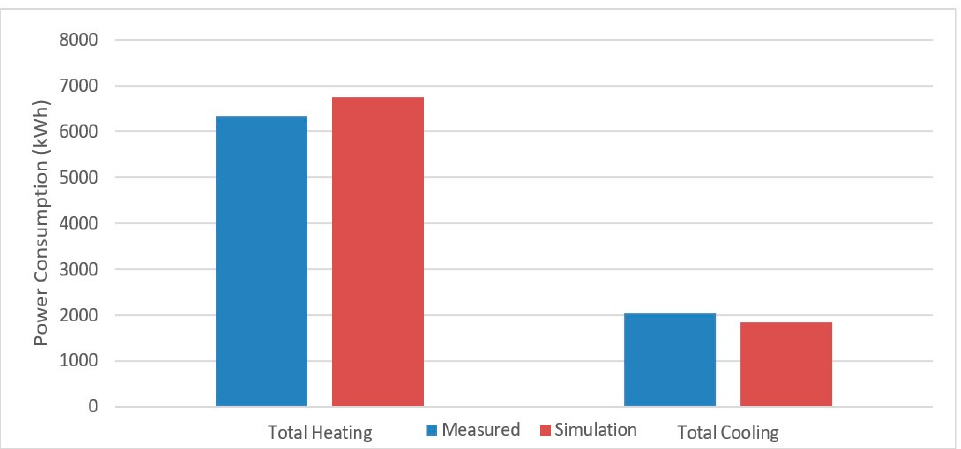
Figure 12. The measured and simulated electrical energy consumption in winter and summer (heating and cooling) .